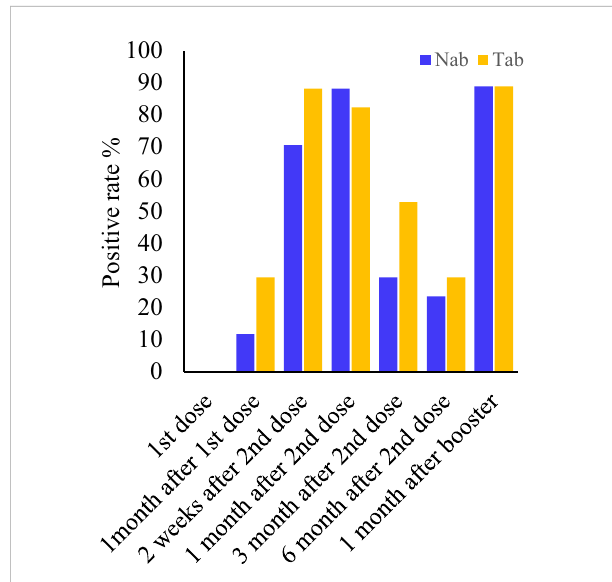
FIGURE 1 Positive rates of the Pylon TAb assays and the Pylon NAb assays at each time point. Time point (TP) 1-7: at the injection of the fi rst dose, at the injection of the second dose (or ~1 month after the fi rst dose), two weeks after second dose, 1 month after the second dose, 3 months after the second dose, 6 months after the second dose and 2 weeks-1 month after the third dose (or ~10 months after the fi rst dose).